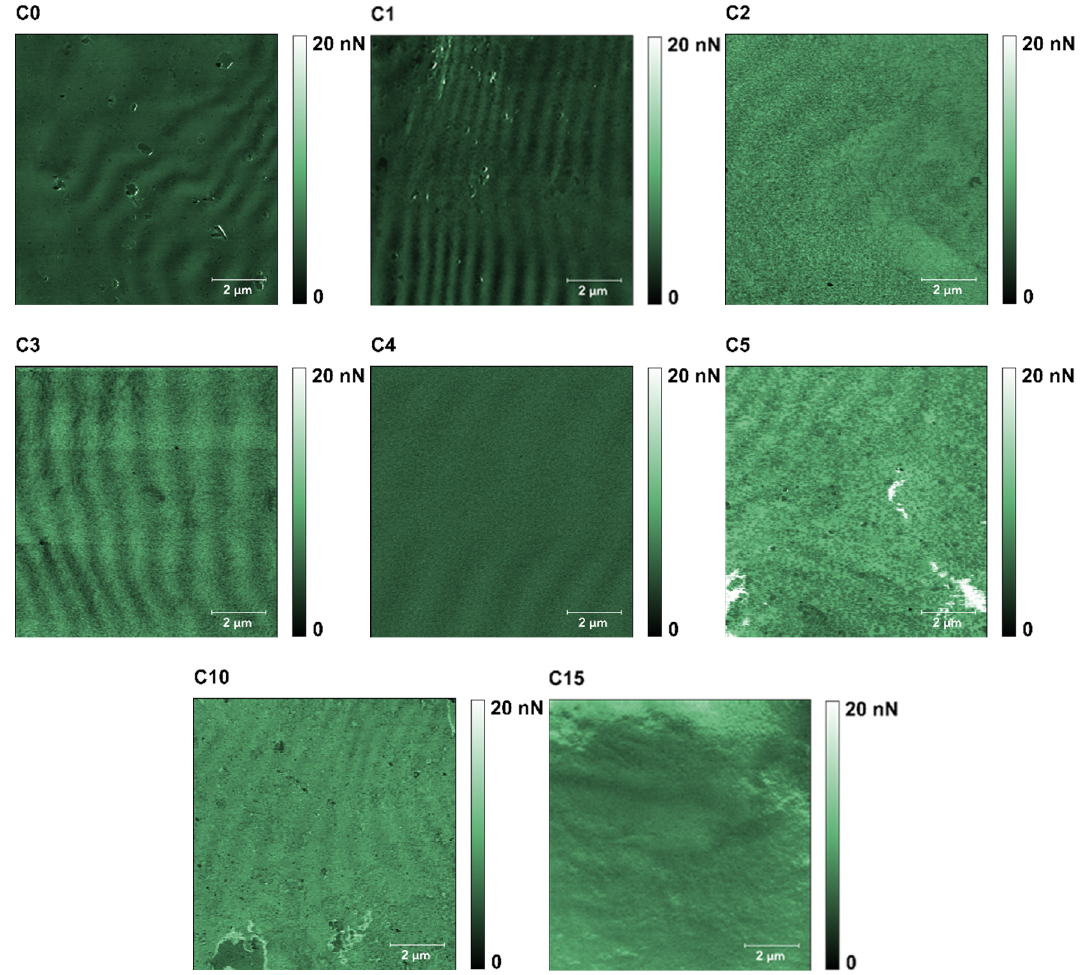
Figure 5. Representative maps of the adhesion forces (10 × 10 µm) for the samples C0–C5, C10, and C15.